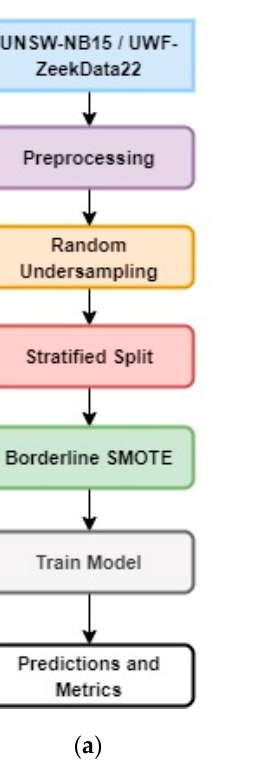
Figure 1. Experimental design: ( a ) Resampling Before Spli tt ing; ( b ) Resampling After Spli tt ing.